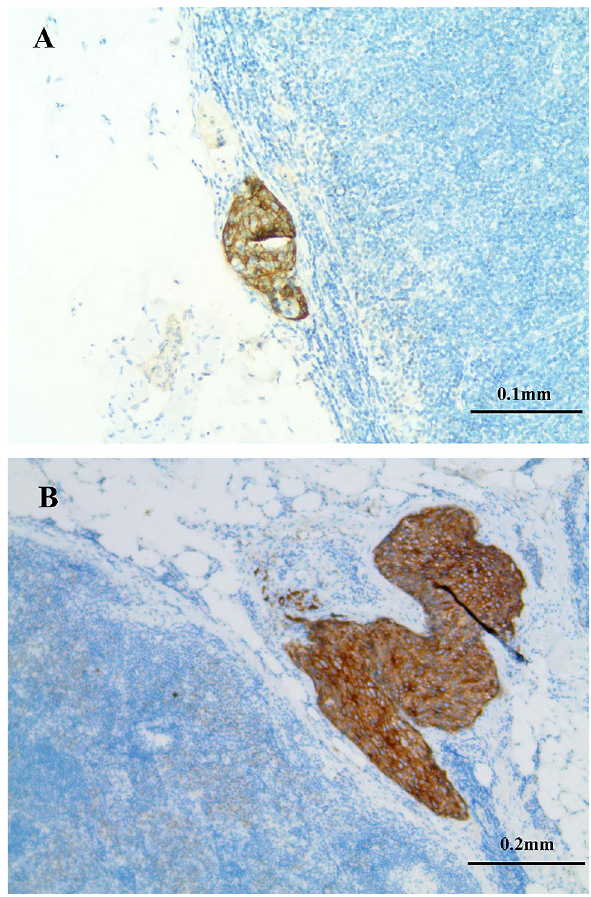
Figure 2. ( A ) Isolated tumor cells in lymph nodes, detected by immunohistochemical for AE1/AE3 (the size ≤ 0.2 mm). ( B ) Micrometastases in lymph nodes, detected by immunohistochemical for AE1/AE3 (the size > 0.2 mm and ≤ 2.0